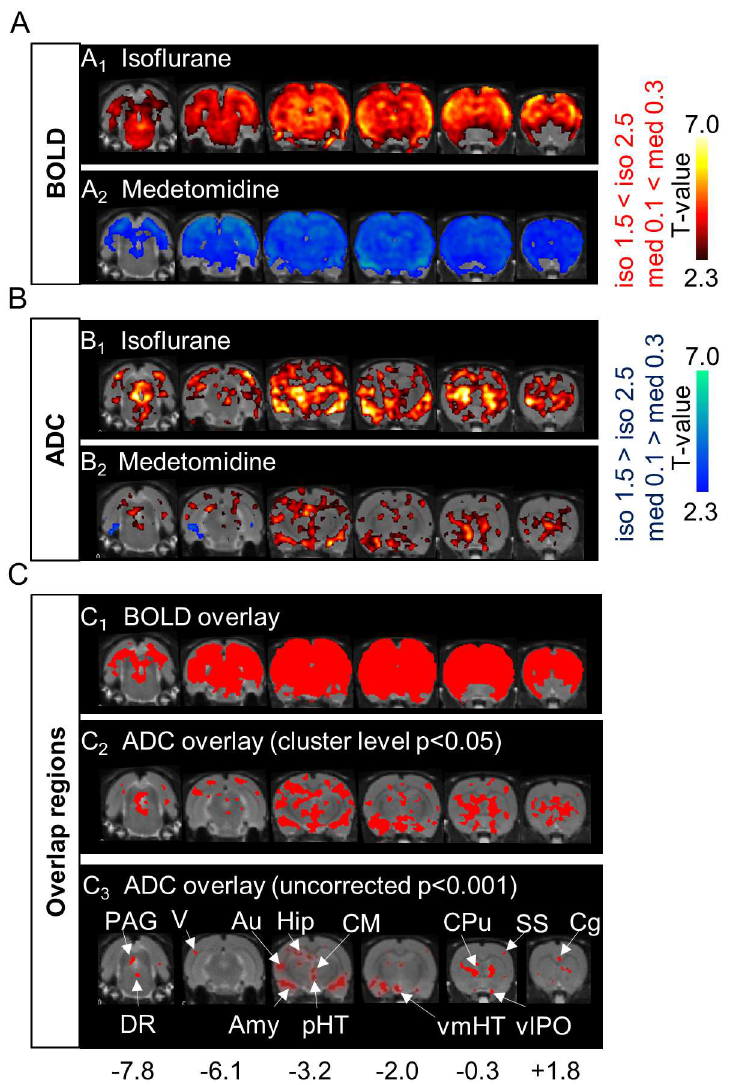
Fig 1. Comparison of Blood Oxygenation Level—Dependent (BOLD) and Apparent Diffusion Coefficient (ADC) maps under both anesthetic conditions. (A, B) T-maps of changes in BOLD signals (A 1 ; n = 6, A 2 ; n = 7) and ADC (B 1 ; n = 10, B 2 ; n = 8) under isoflurane(iso) and medetomidine (med) dosage conditions (six out of ten slices are shown. Hot colors mean an increasein BOLD or ADC of high dose (cluster-level corrected p < 0.05), comparedwith that of low dose. Cool colors mean the opposite(cluster-level corrected p < 0.05). (C 1 ) Red regions correspond to regions associatedwith both a BOLD increase for iso and a BOLD decrease for med (cluster-level corrected p < 0.05). (C 2 , C 3 ) Red regions correspond to regions showingan ADC increase(C 2 ; thresholdof cluster-level corrected p < 0.05, C 3 ; thresholdof uncorrected p < 0.001) common to both med and iso. With the stricter statistical threshold (C 3 ), small regionslike the central medial thalamusnucleus(CM) and some hypothalamic nuclei (posterior hypothalamic nucleus[pHT], ventral medial hypothalamic nucleus[vmHT], ventrolateral preoptic nucleus[vlPO]) are easier to see. Numbersat the bottom correspondto the distance(mm) from the bregma. Statistical maps for group analysis and overlaymaps of BOLD and ADC can be found in S7 Data. the insular cortex, the posterior thalamic area, and the superior colliculus. The common regions exhibiting the ADC increase under both anesthetic conditions were the cerebral cor- tex (the somatosensory cortex, the cingulate cortex, the auditory cortex, the visual cortex), the limbic region (the Caudate-Putamen, the hippocampus, the amygdala, the thalamus, the